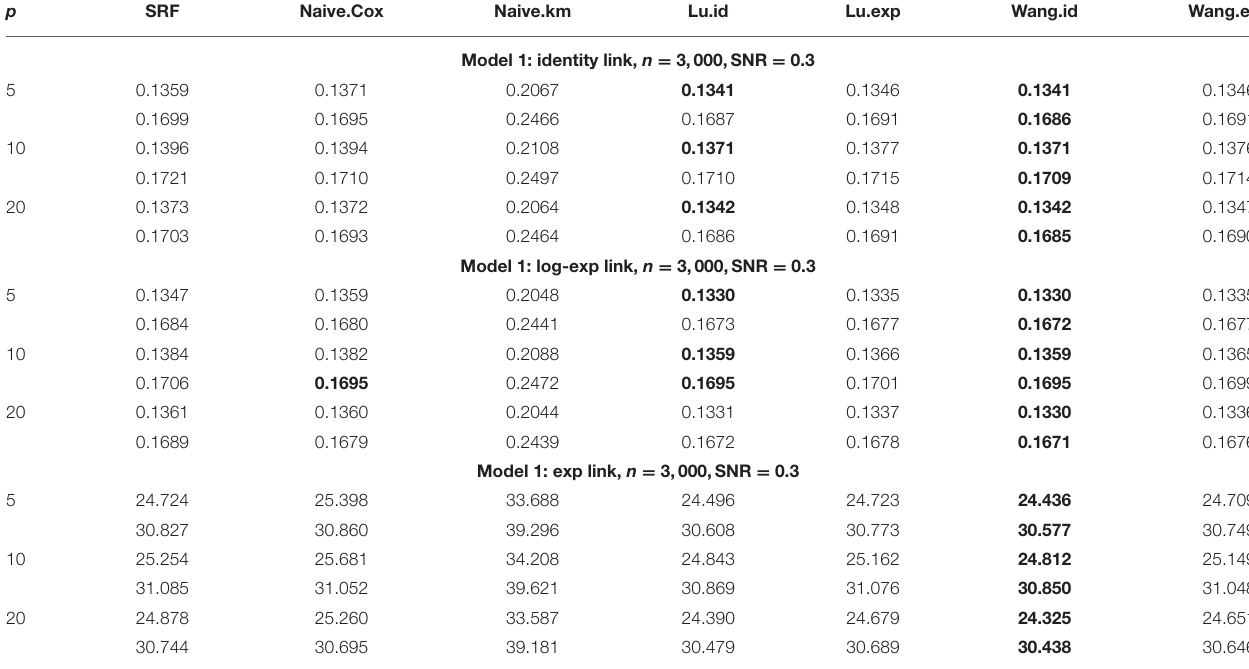
TABLE 1 | Comparison of Mean-Absolute-Error (MAE) and Rooted-Mean-Squared-Error (RMSE) for Model 1 with different link functions. p SRF Naive.Cox Naive.km Lu.id Lu.exp Wang.id